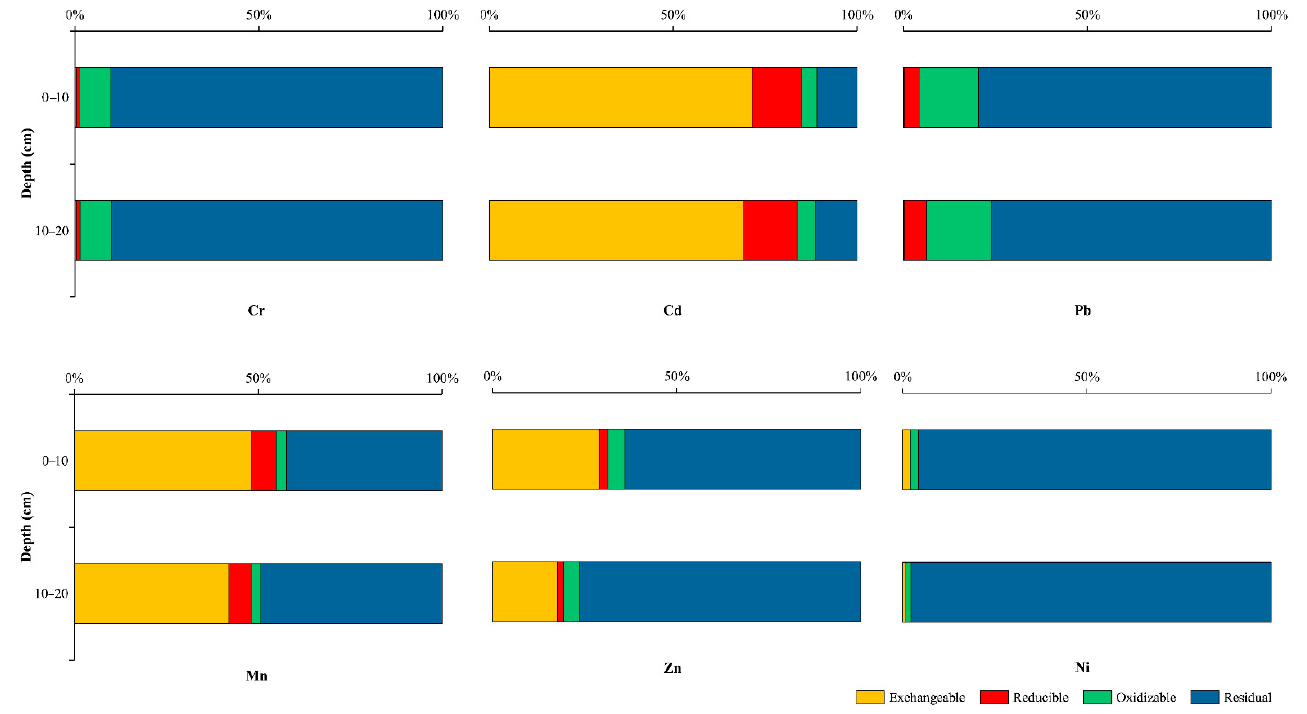
Figure 6. Percentage of each speciation for heavy metals in profile samples in HFR.